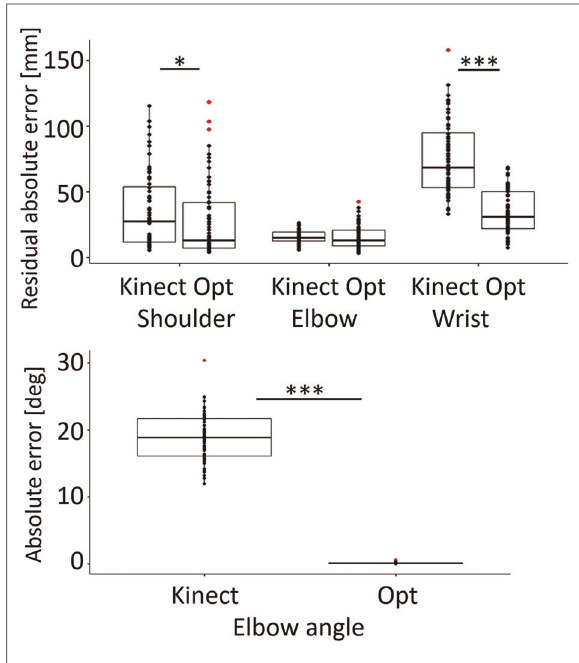
FIGURE 5 Top: Boxplot and data points for the absolute residual error with respect to the OptiTrack data of the shoulder, elbow, and wrist joint positions of the Kinect recording and the of fl ine optimization. Bottom: Boxplot and data points of the absolute error of the elbow angle calculated from the Kinect measurements and from the of fl ine optimization with respect to the goniometer measurements. Kinect: Kinect recording error, Opt: optimization error. Red points represent outliers. * p <0.05, *** p